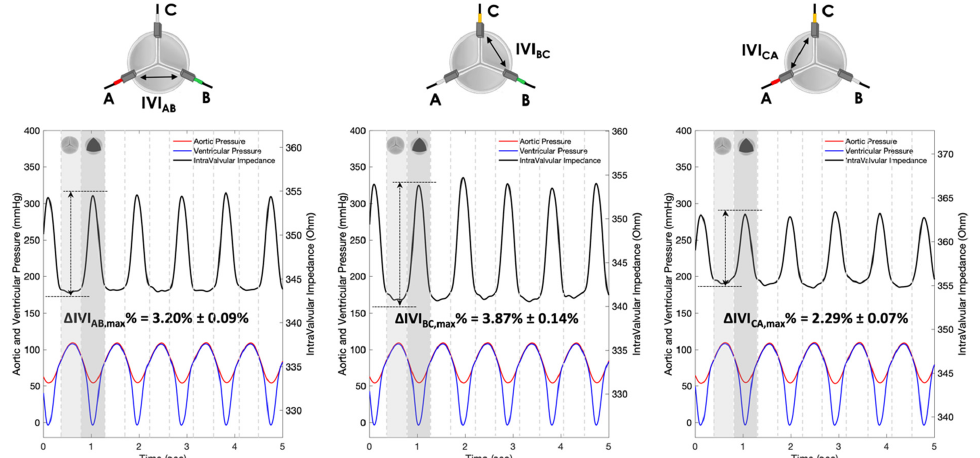
Figure 10. IVI measurements recorded for the three pairs of electrodes of Prototype 1 under normal leaflet dynamics: AB ( left ), BC ( center ) and CA ( right ).